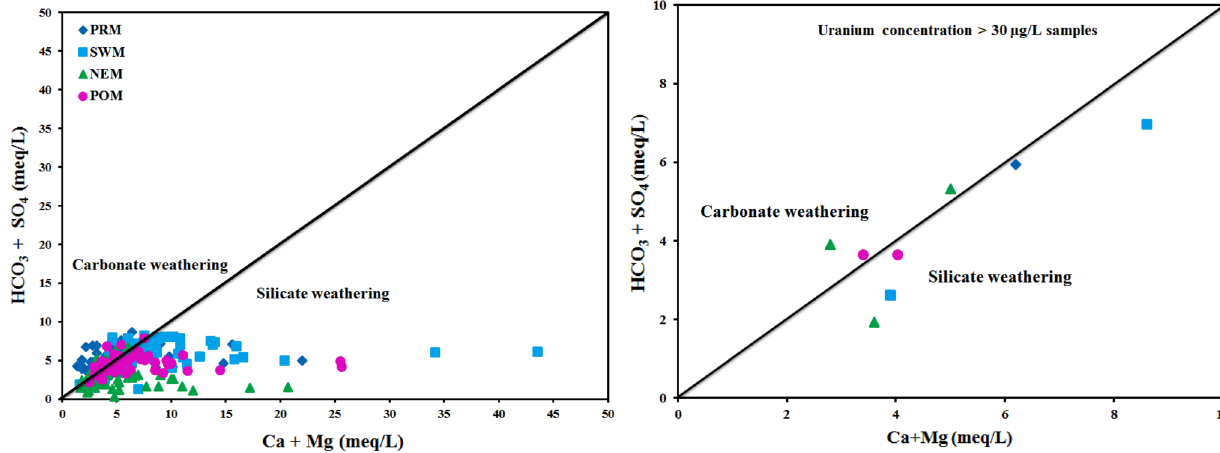
Fig. 10 (Ca + Mg) vs. (HCO 3 + SO 4 ) scatter diagram showing the carbonate dissolution and silicate